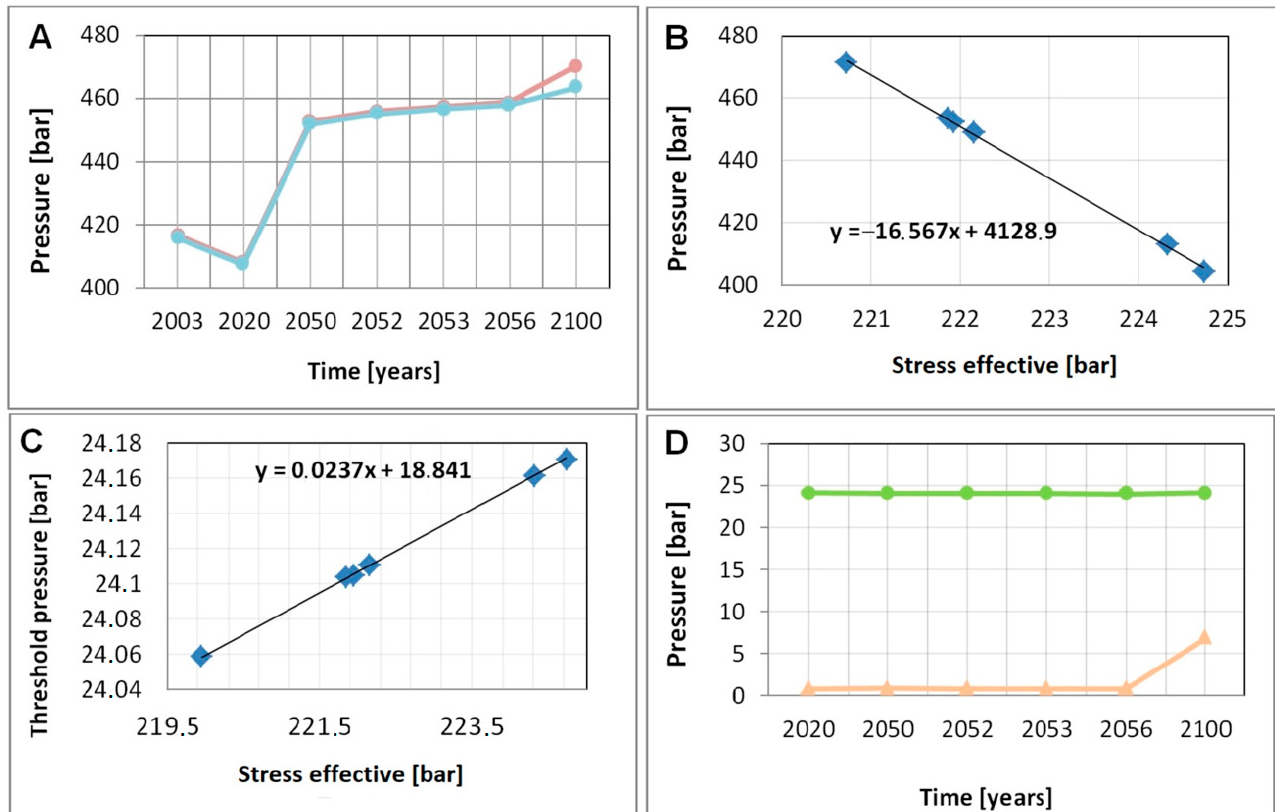
Figure 21. ( A )—Pressure evolution in the top of the reservoir Ca2 (red line) and basal anhydrite A2 (blue line), ( B )— relationship between the magnitude of the minimum horizontal stress and reservoir pressure, ( C )—relationship between the magnitude of the minimum horizontal stress and threshold pressure, ( D )—evolution of the threshold pressure (green line) and pressure step between the top of the reservoir and basal anhydrite (orange line) during the history of exploitation and injection of CO 2 into the reservoir rock.